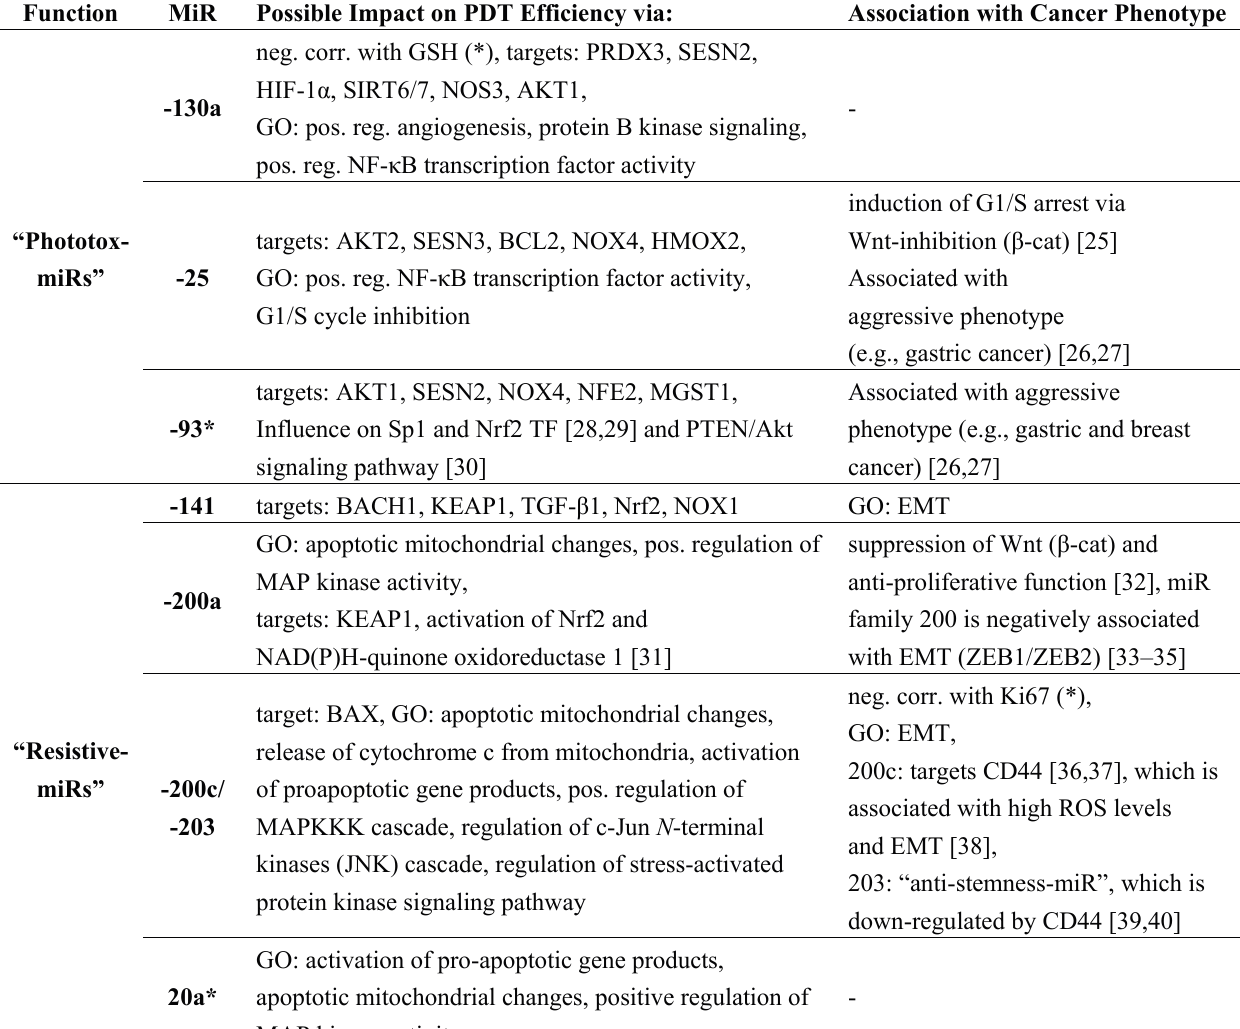
Table 3. Summary of combined bioinformatic approach and literature search after in silico target prediction for phototox- and